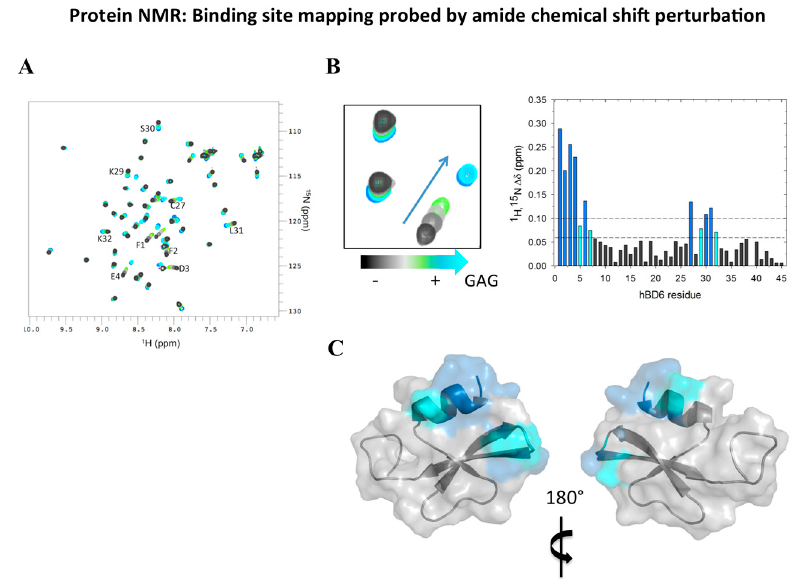
Figure 4. Nuclear magnetic resonance (NMR) as a tool to determine ligand ‐ defensin complex formation. ( A ) Once the backbone chemical shift assignment is accomplished, a 1 H ‐ 15 N heteronuclear single quantum coherence (HSQC) spectrum of the free protein containing the assigned amide groups is obtained. ( B ) Titration of an unlabeled ligand (in this example, a glycosaminoglycan [GAG]) bound to 15 N ‐ labeled human β‐ defensin (HBD)6 results in a chemical shift perturbation map of HBD6 ‐ ligand interactions. The NMR titration revealed large changes in the chemical shift of HBD6 in a fast ‐ exchange equilibrium between free and GAG ‐ bound HBD6, as demonstrated by a gradual shift in peak positions in 1 H ‐ 15 N HSQC spectra. ( C ) The amide groups significantly perturbed upon GAG binding are highlighted on the HBD6 surface (protein data bank: 2LWL) in blue and cyan to map the binding sites for the GAG. Figure adapted from [41]. For further details see Section 2.5.